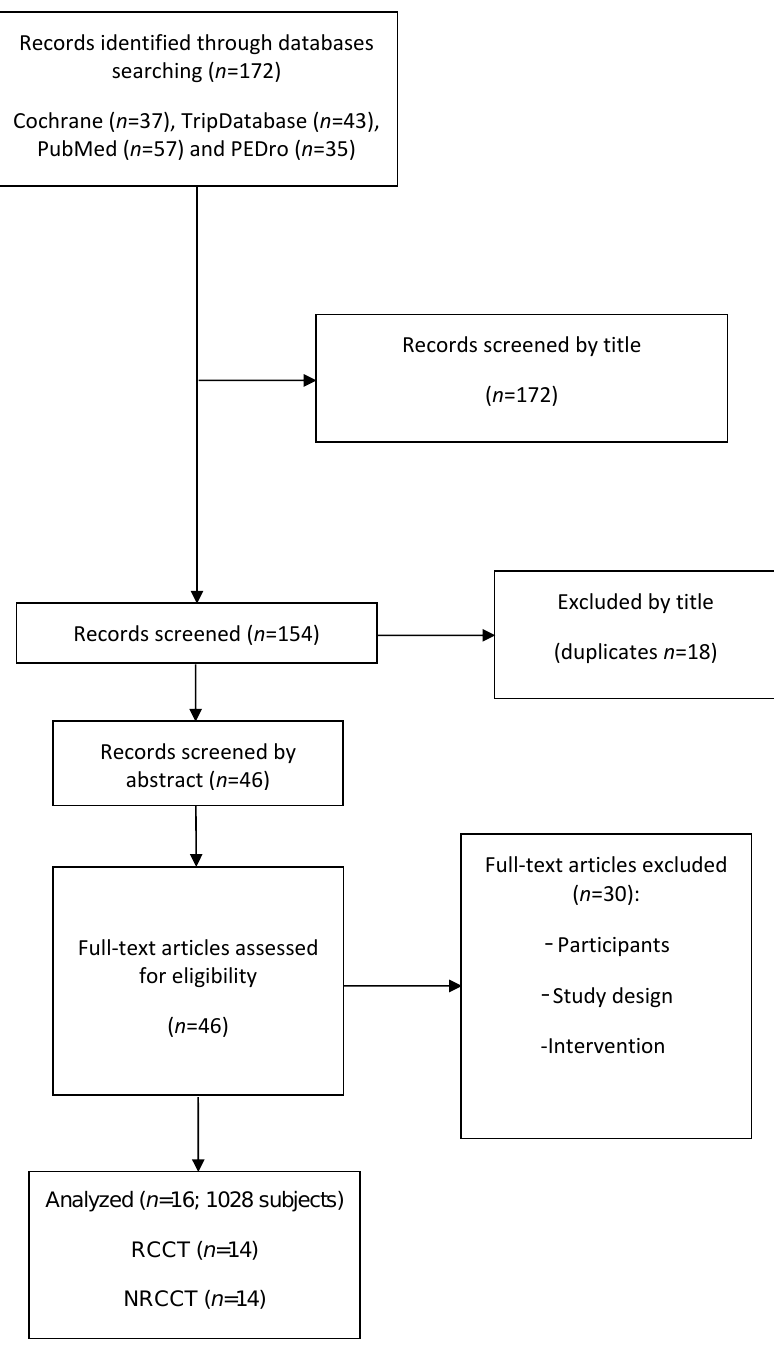
Figure 1. PRISMA Flow